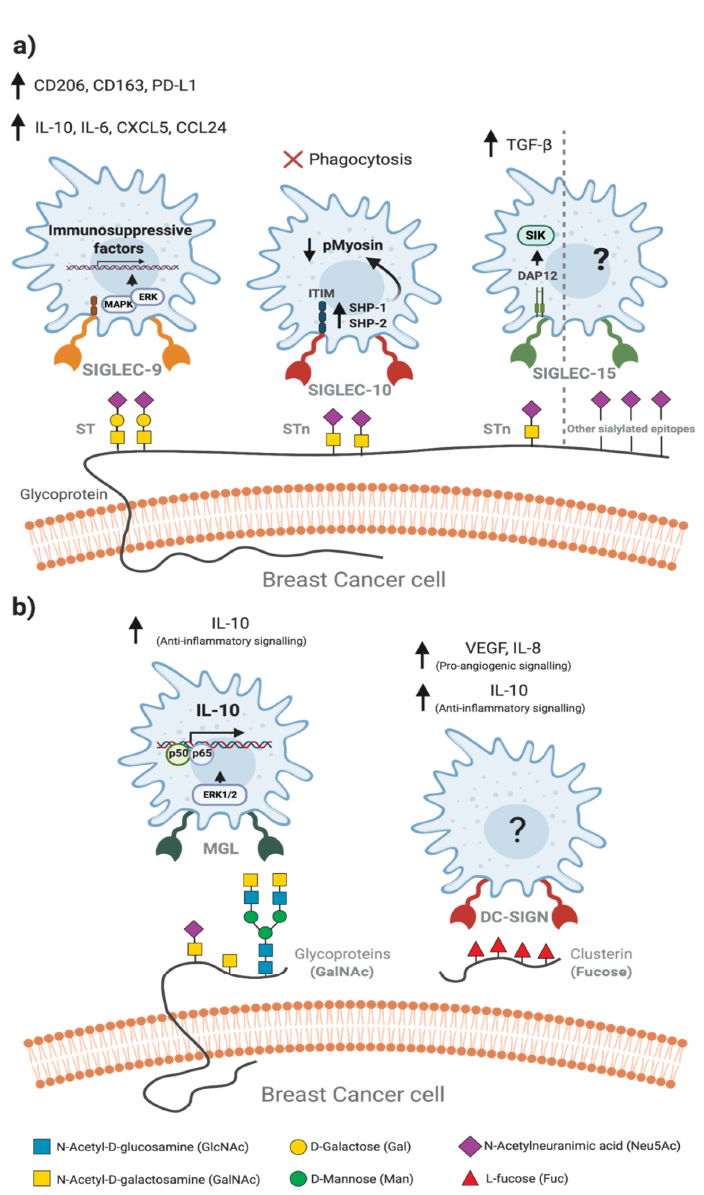
Figure 3. Glycan-lectin interactions within the breast cancer microenvironment modulate the phenotype of tumour- associated macrophages. The binding of lectins (glycan binding receptors) on macrophages to aberrant glycans exposed at the surface of BC cells induces a protumour phenotype in macrophages, promoting immunosuppressive functions. ( a ) Few glycan-lectin interactions are currently known, being the most described the interactions between sialylated epitopes of BC cells and sialic acid-binding immunoglobulin-like lectins (SIGLECs). The recognition of ST-enriched MUC1 by SIGLEC-9 activates the MAPK-ERK pathway, increasing the expression of immunosuppressive factors, which induces the protumour phenotype of other infiltrating immune cells. Sialyl T (ST) and sialyl Tn (STn) antigens are recognized by SIGLEC-10, triggering an immunoreceptor tyrosine-based inhibitory motif (ITIM)-mediated signalling which recruits Src homology 2 (SH2)-domain-containing protein tyrosine phosphatase 1 (SHP1) and SHP2 tyrosine phosphatases. These phosphatases inhibit the phosphorylation of myosin, hampering the motility of macrophages membrane and engulfment of tumour cells. SIGLEC-15 has been described to bind STn, inducing a DAP12-mediated cascade that triggers an increased secretion of TGF- β . In another recent study, SIGLEC-15 showed higher binding avidity for other sialylated glycans, not triggering TGF- β secretion, but instead activation of the SYK/MAPK signalling pathway. SIGLEC-15-glycan interactions within TME remains an open question. ( b ) Terminal GalNAc on tumour cells is recognized by macrophage galactose-like lectin (MGL), upregulating the ERK pathway and the expression of IL-10, via NF- κ B. Some studies also report the role of clusterins in TAM modulation. Although much is not understood in this interaction, clusterin-stimulated macrophages were shown to polarize into a proangiogenic, anti-inflammatory phenotype, with increased secretion of VEGF, IL-8 and IL-10. Monosaccharides are represented according to the symbol nomenclature for glycans (SNFG)